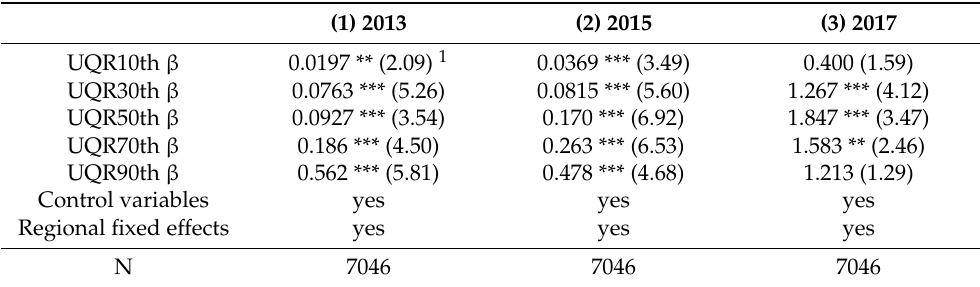
Table 5. Unconditional quantile regression (UQR) results of financial cognitive level on rural house- hold